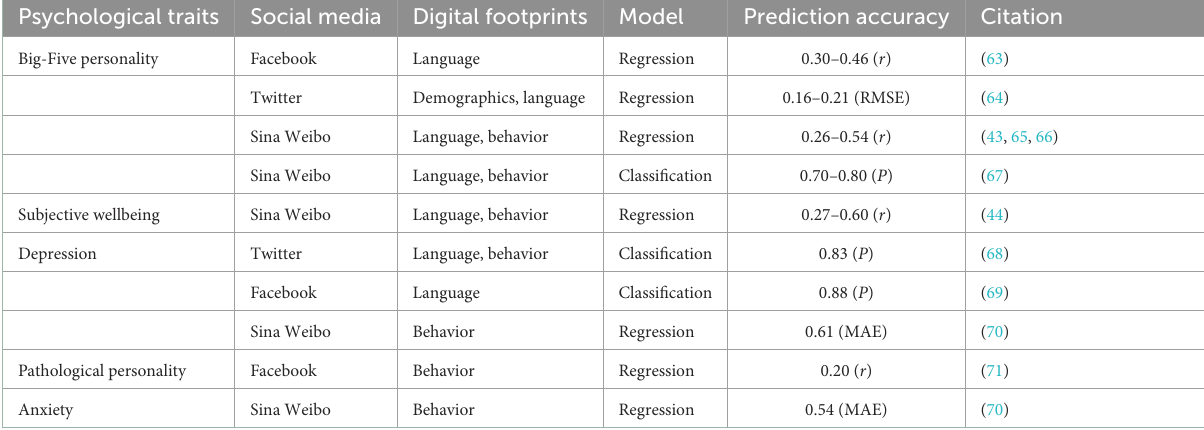
TABLE 1 Examples of the psychological traits prediction studies based on social media